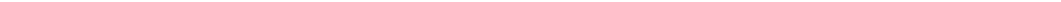
Figure 1: Proportion of ever-seropositive children in the canton of Zurich among districts (upper), schools (middle) and classes (lower) at T2 (October-November 2020), T3 (March-April 2021) and T4 (November-December 2021). Each district has an individual colour in the upper pan- els, primary school children (grades 2–6) in light blue and secondary school children in dark blue (medium and lower panels). Boxplots in the lower panels denote median and describe variability of seroprevalence on a school level expressed as maximum seroprevalence in a class mi- nus minimum seroprevalence and summarised as median (interquartile range). Whiskers of boxplots denote ± 1.5 standard deviation (SD).